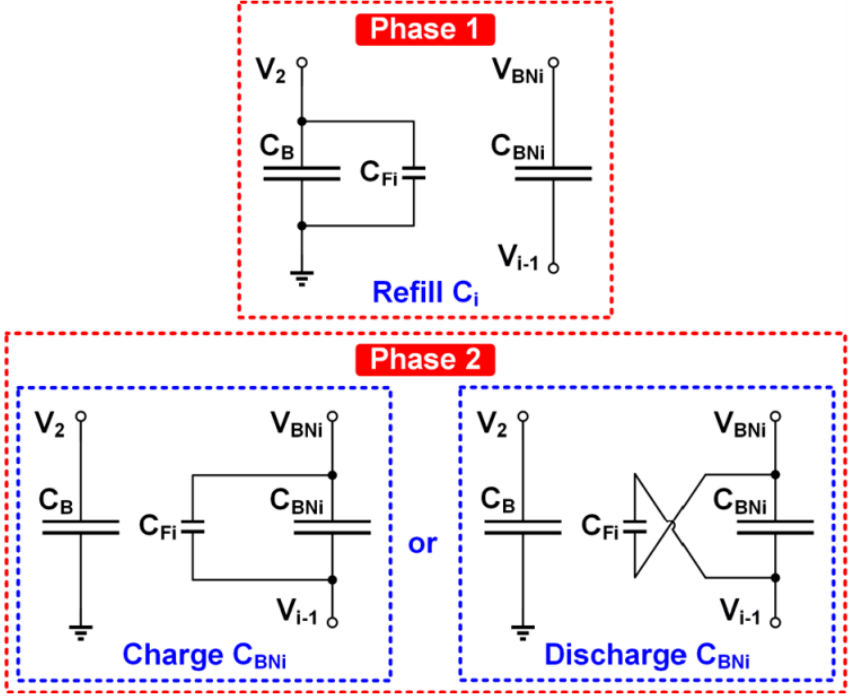
Figure 22. Single stage of the switched-capacitor-based charge pump integrator for ABT. An active rectifier with digitally controlled on-off delay-compensated for biomedical application is introduced in [51]. It consists of two NMOS active diodes and a cross-coupled PMOS transistor-pair (Figure 23). High efficiency is achieved by digital techniques that eliminate turn-on delay, reverse current and multiple